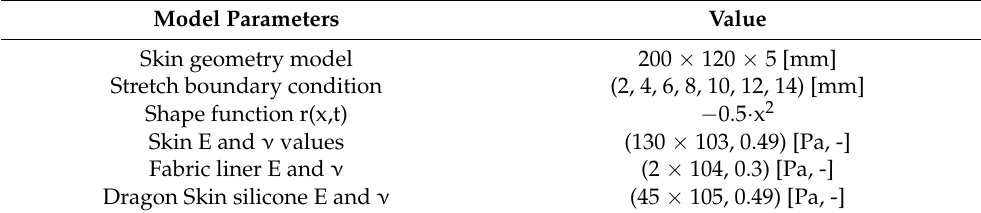
Table 1. Values of model parameter employed in numerical simulation.